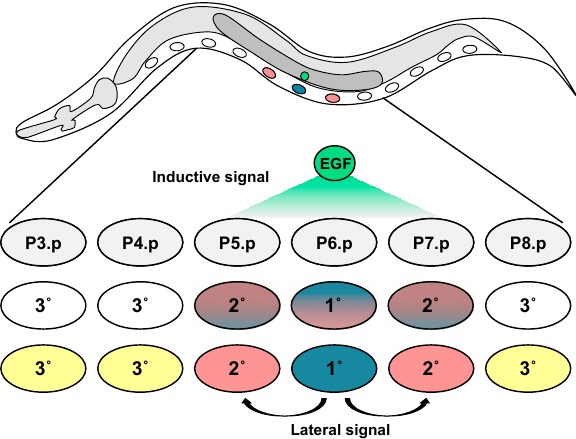
Figure 2. Overview of the C. elegans VPC fate patterning. The six naïve VPCs are numbered P3.p through P8.p. P6.p, closest to the Anchor Cell (AC), receives the highest level of EGF inductive signal and assumes 1 ◦ fate. P5.p and P7.p receives lower levels of inductive signal and lateral Notch signal from the P6.p to assume 2 ◦ fate. P3.p, P4.p, and P8.p receive insufficient inductive and lateral signals and adopt nonvulval fates.